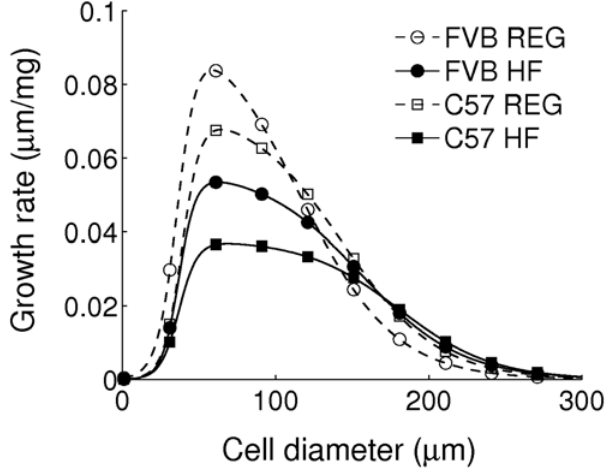
Figure 6. Size-dependent growth rate v for the increment of epididymal fat pad mass. Here the mean parameter values in Table 2 are used for this plot. Symbols are shown to aid comparison between